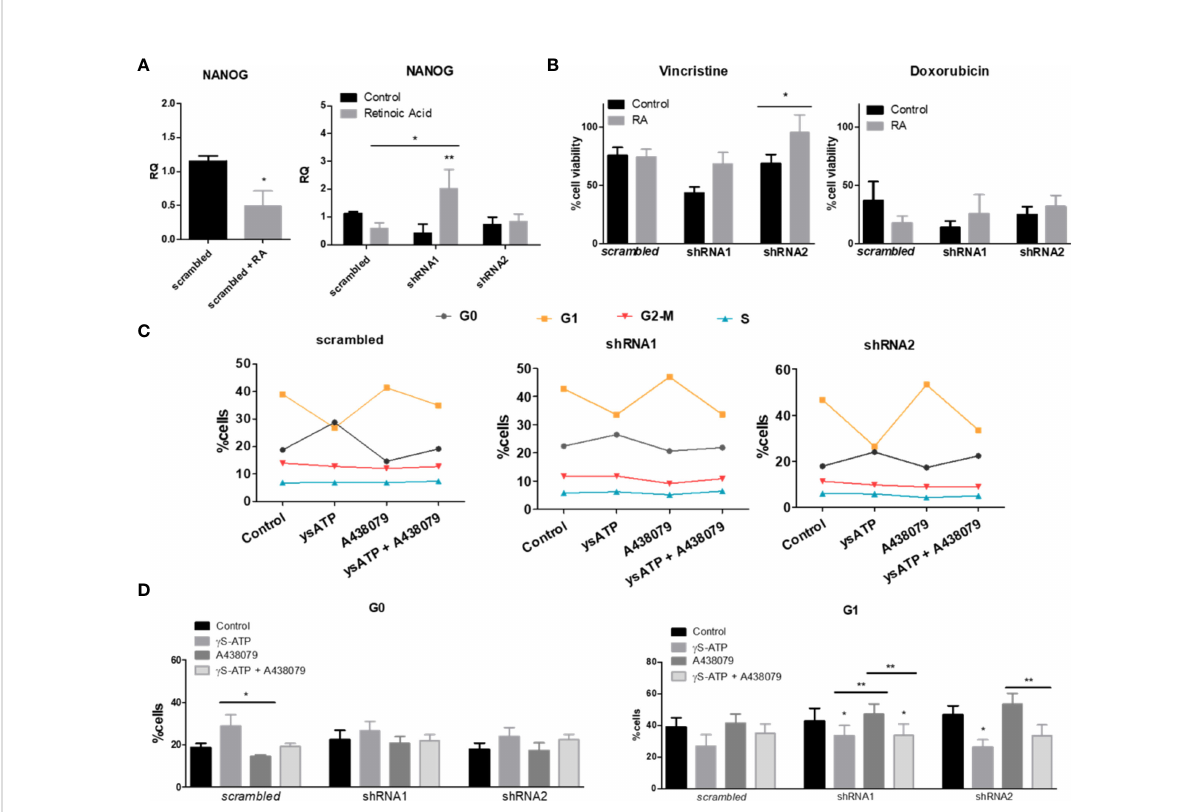
FIGURE 5 Retinoic acid-induced differentiation and cell cycle in NB cells differentially expressing P2X7 receptor isoforms. (A) NANOG mRNA expression levels in ACN cells treated with the neural differentiation inducer retinoic acid (RA) at a 5 µM concentration (n=4). (B) Cell viability measurements of ACN cells treated with RA and/or vincristine or doxorubicin (n=3). Values were calculated as detailed in Methods section item 5. (C) Complete representation of cell cycle phases of ACN cells after treatment with P2X7 receptor agonist and/or antagonist (n=5). (D) Distribution of ACN cells in cell cycle phases G0 and G1 after treatments with ysATP (an ATP analog resistant to hydrolysis), A438079 (selective P2X7 receptor antagonist) or both (n=5). * p <0.05; ** p